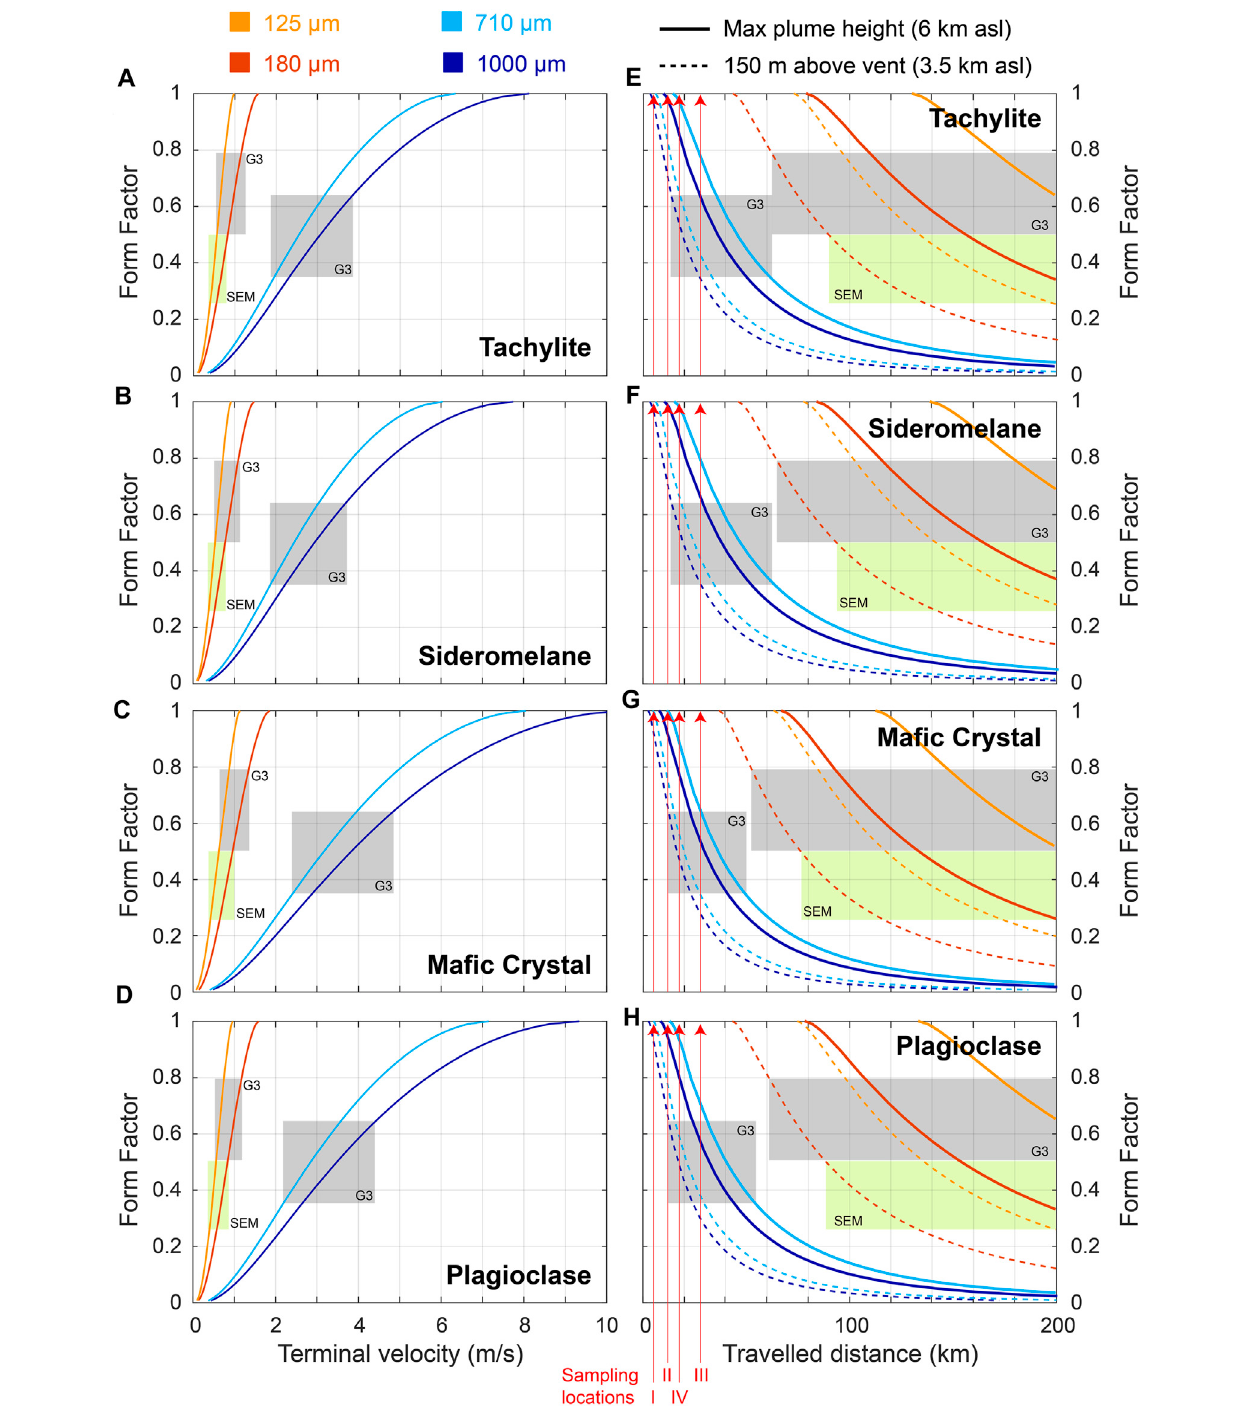
FIGURE 9 | (A – D) Variations of the terminal fall velocity (Vt, taken here at 2 km a.s.l.) of each textural component with the Form Factor (FF) of the grains. (E – H) Variations of the distance travelled by each textural component with